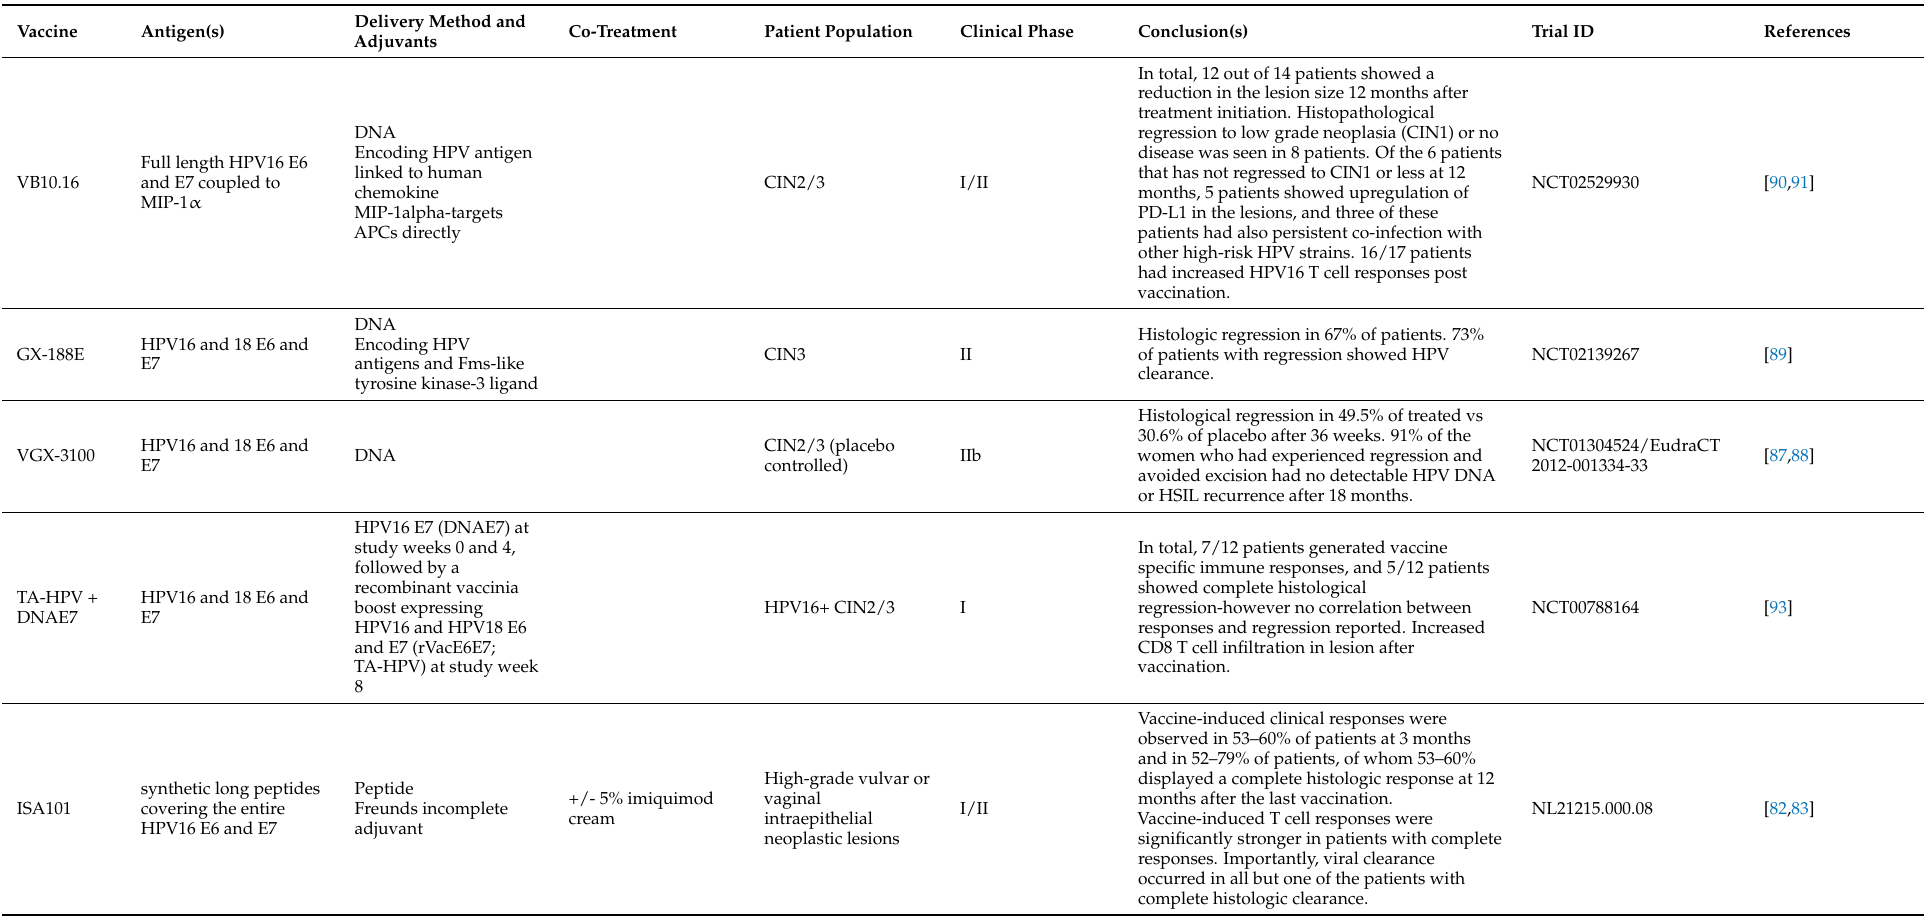
Table 1. Summary of recent clinical trials of HPV therapeutic vaccines against cervical dysplasia